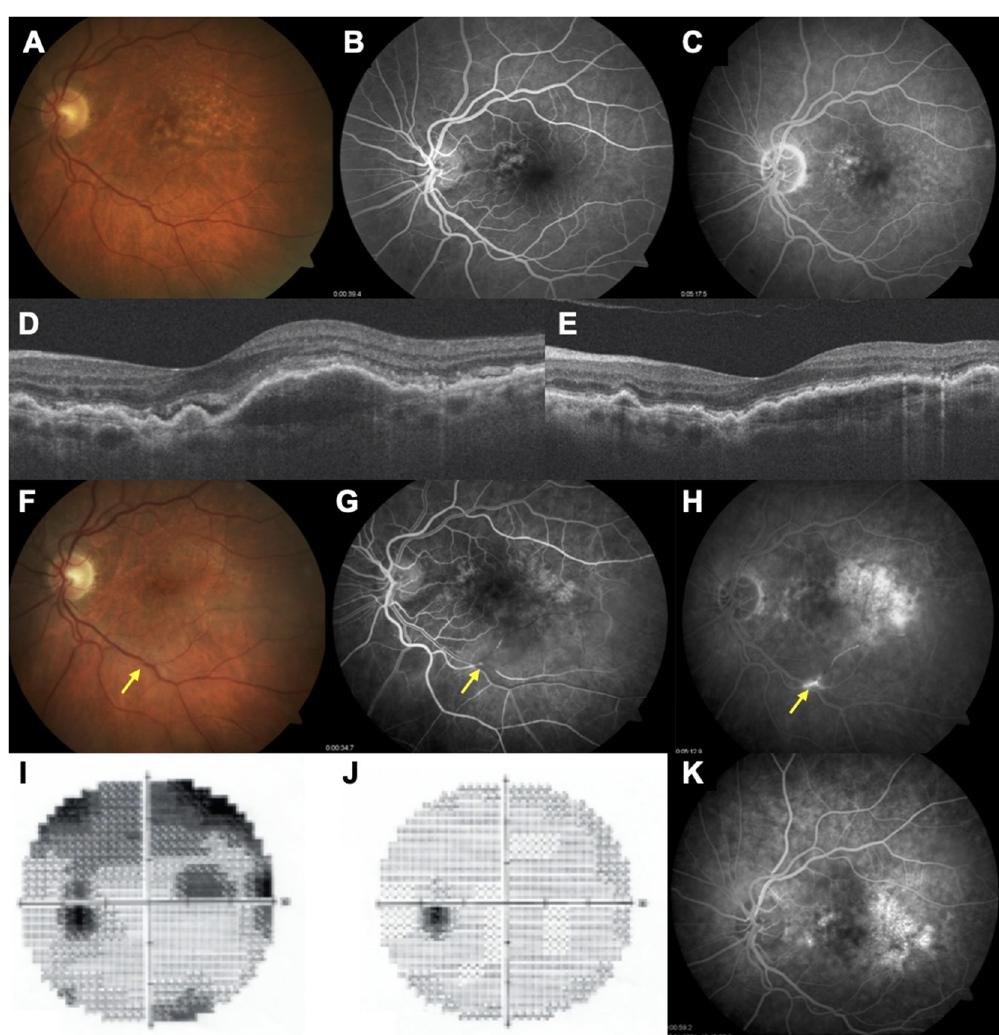
Figure 4. A 71-year-old woman with neovascular AMD had received 70 injections prior to initiation of brolucizumab therapy. ( A – C ) Multimodal imaging showing the baseline situation before any anti-VEGF therapy. ( D ) SD-OCT immediately prior to initiation of brolucizumab therapy. ( E ) SD-OCT after the first brolucizumab injection showing total resorption of subretinal fluid and decrease of the pigment epithelium detachment. The patient complained of loss of vision 7 days after the fifth brolucizumab injection. ( F – I ) Multimodal imaging showing an retinal arterial occlusion in her left eye (arrow); perimetry analysis demonstrates a corresponding superior scotoma. She had presented within 4 h of onset of symptoms and was immediately referred to the emergency room and received low molecular weight heparin. ( J , K ) Post-heparin analysis showing perimetry recovering and arterial reperfusion.